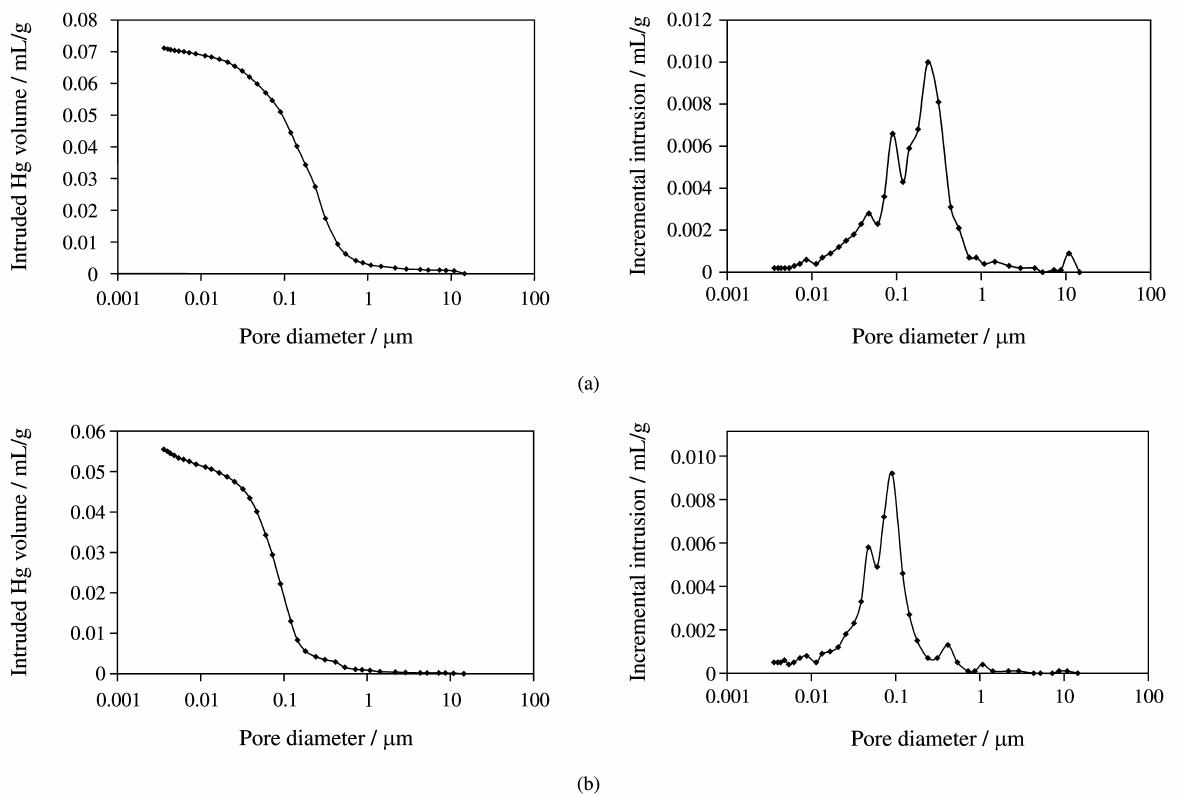
Figure 1. Intruded Hg volume vs. pore diameter curves and incremental intrusion vs. pore diameter curves, obtained from mercury intrusion porosimetry tests of non heat-treated concrete specimens: (a) f ck of 20 MPa; (b) f ck of 50